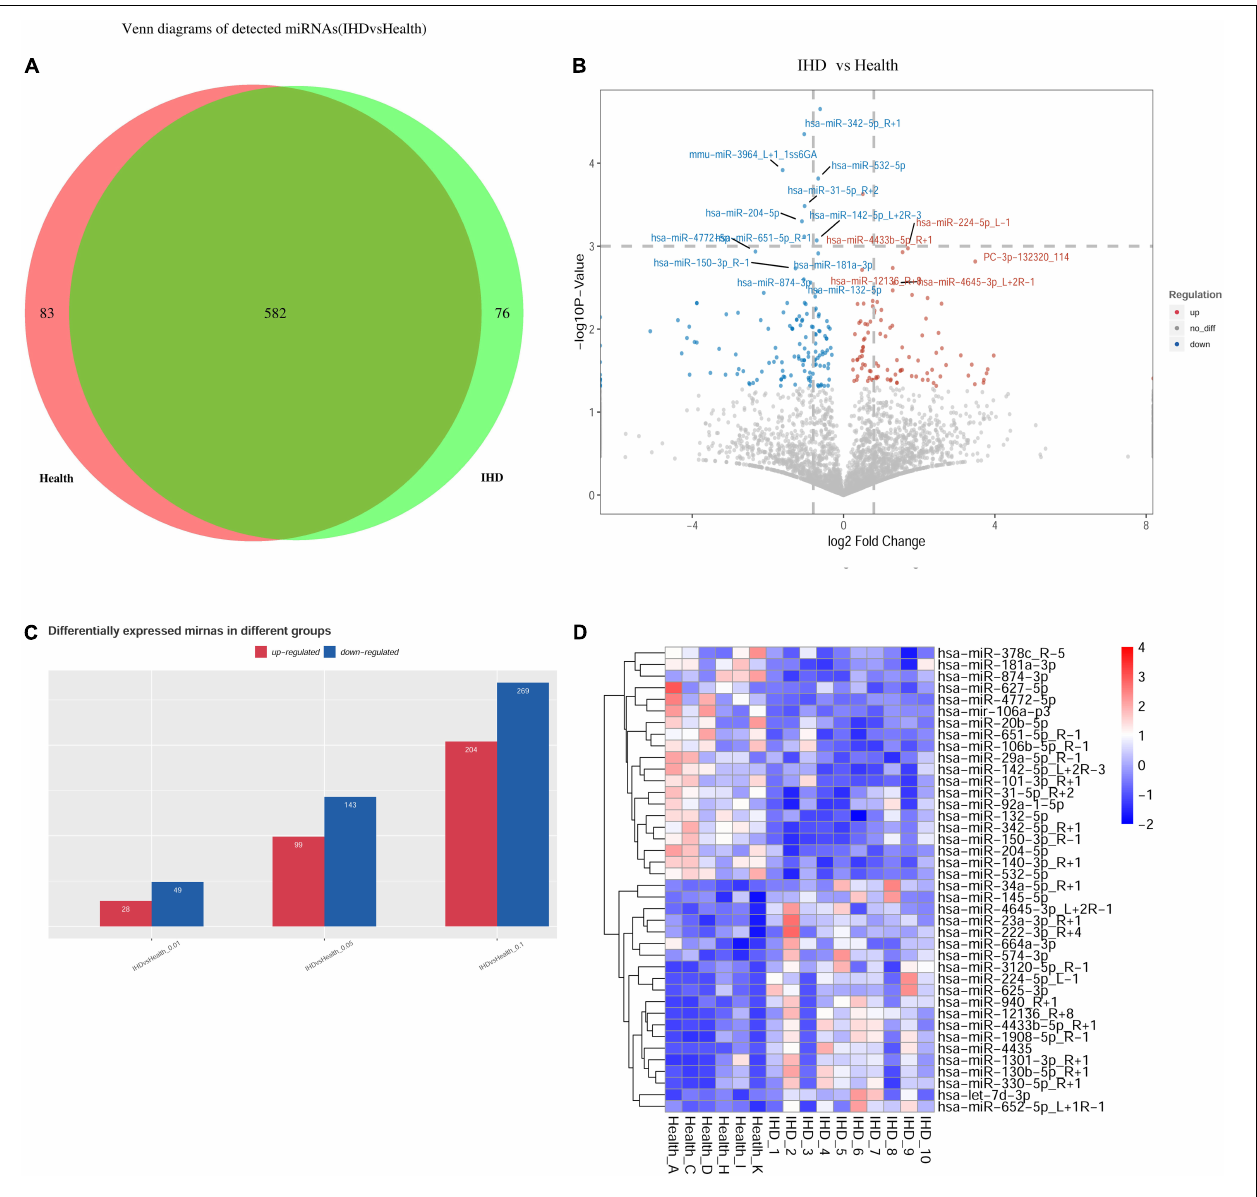
FIGURE 2 | Profile of exosomal microRNAs (miRNAs) using high-throughput sequencing. (A) Venn diagram showed overlapping miRNAs between healthy volunteers and patients, where 76 miRNAs were specifically detected in ST-segment elevation myocardial infarction (STEMI). While 83 miRNAs were specifically detected in healthy volunteers, 582 miRNAs showed no statistically significant difference between them. (B) The overall distribution of differentially expressed miRNAs was shown in volcano plots using log2(fold change) as the horizontal coordinate and –log10 ( p- value) as the vertical coordinate. (C) Bar plot: Differentially expressed miRNA was observed, including 28 upregulated miRNAs and 49 downregulated miRNAs ( p < 0.01). (D) Heatmap in patients with STEMI after 3–6 months ( n = 10) and healthy volunteers ( n = 6) uncovered the similarity of miRNA expression profiles of the discovery group by clustering miRNAs, where the top 40 dysregulated miRNAs ( p < 0.05) are shown on the